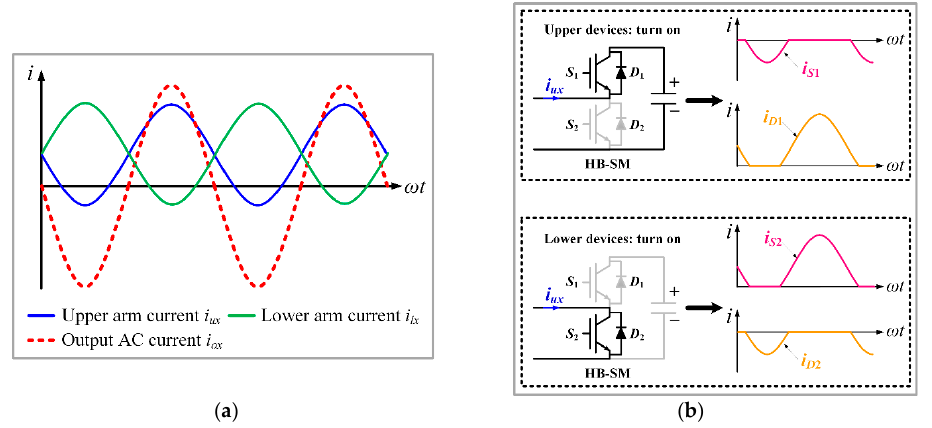
Figure 4. Arm current and upper-arm current flowing through the devices: ( a ) upper, lower, and phase currents; ( b ) upper-arm current flowing through the devices in the half-bridge submodule (HB-SM).